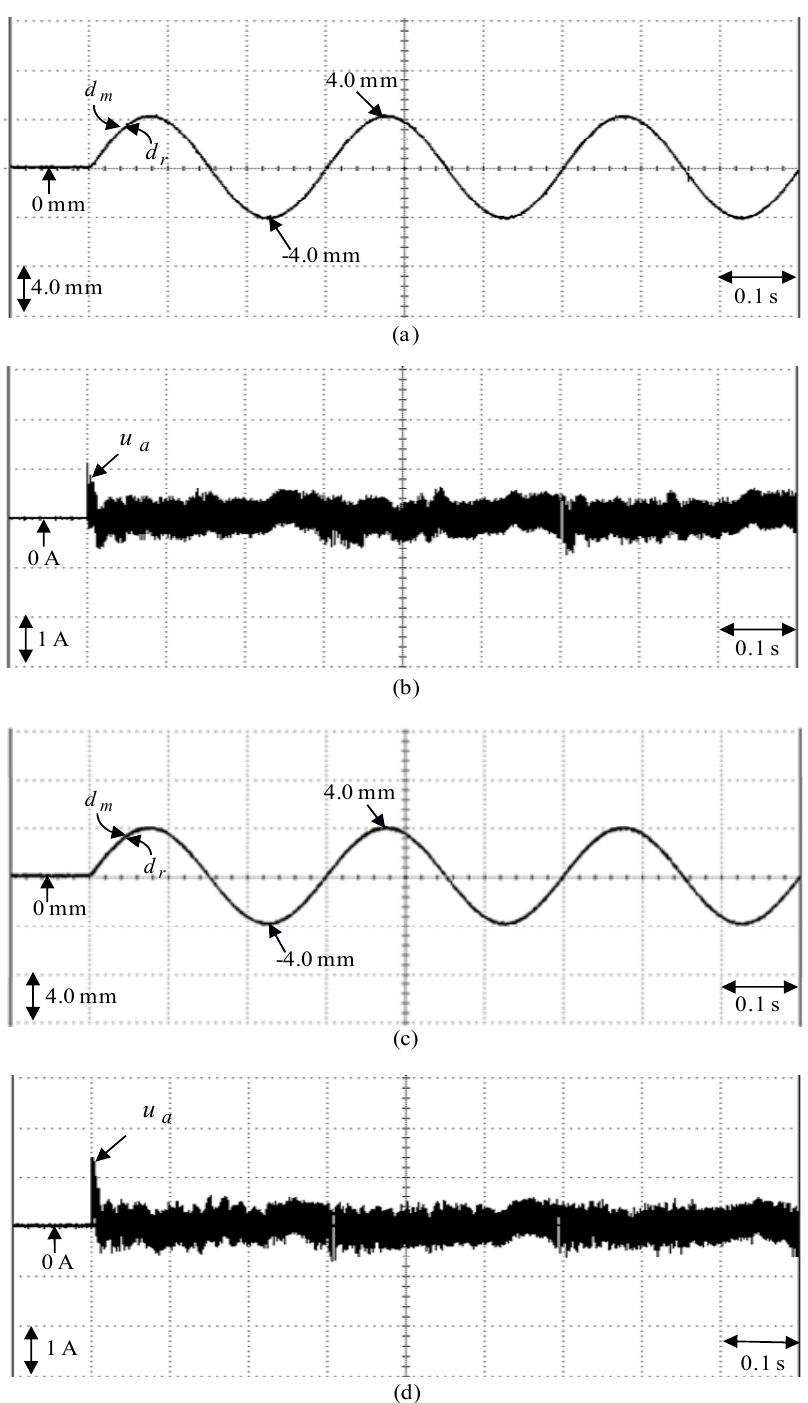
Figure 13. Experimental results of the posed backstepping control system due to periodic sinusoidal command from − 4.0 mm to 4.0 mm: ( a ) position reaction of the mover in Case 3, ( b ) reaction of control effort in Case 3, ( c ) position reaction of the mover in Case 4, ( d ) reaction of control effort in Case 4.